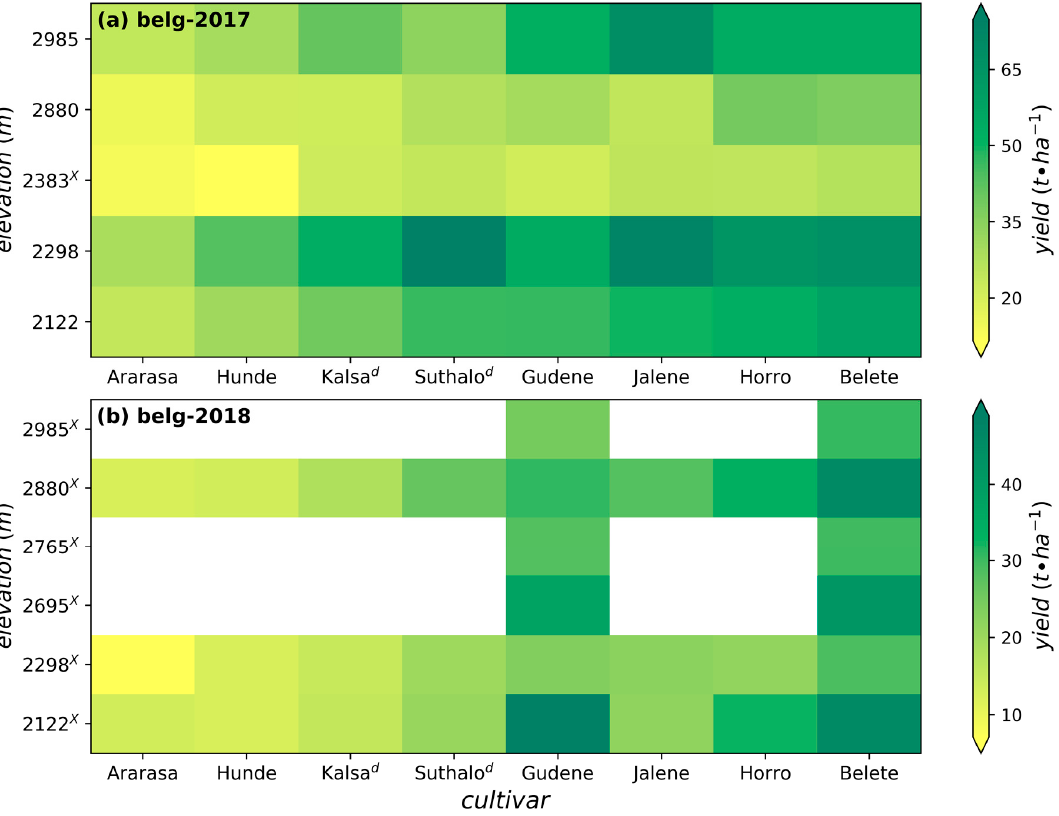
Figure 5. Yield (t · ha − 1 ) variations as a function of elevation (m) associated with the five farms in belg -2017 ( a ) and six farms at different elevations in belg -2018 ( b ), as shown in Table 1. The x -axis shows the eight potato cultivars planted, in order of increasing mean yield ( belg -2017). The white spaces in ( b ) represent missing data. Note that the y -axis are not scaled and each elevation point (not continuous in space) shows an experimental site mentioned in Table 1. Furthermore, the yields during the two belg seasons are so different that the scales of the color-bars are different. The x -axis names with a ‘ d ’ superscript are local cultivars. The ‘ x ’ superscript in the y -axis show farms affected by diseases.